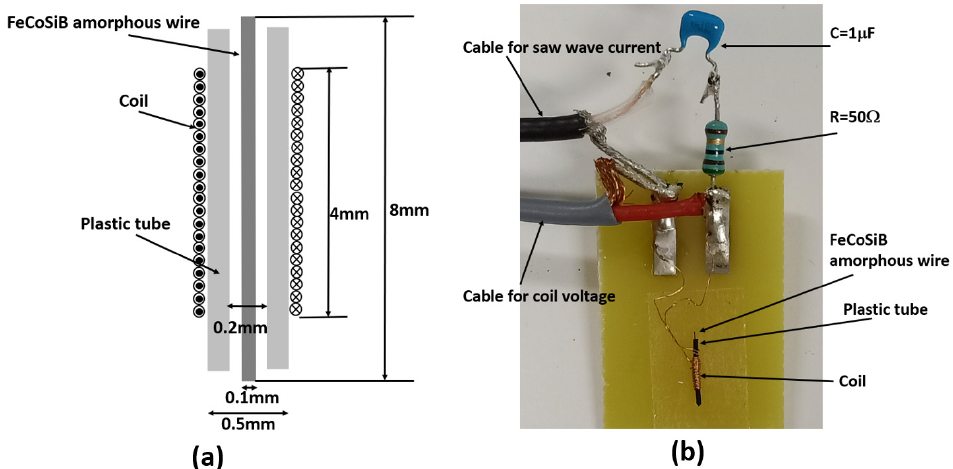
Figure 3. ( a ) Configuration of the coil with FeCoSiB amorphous wire as the coil core. ( b ) Photo of the coil.